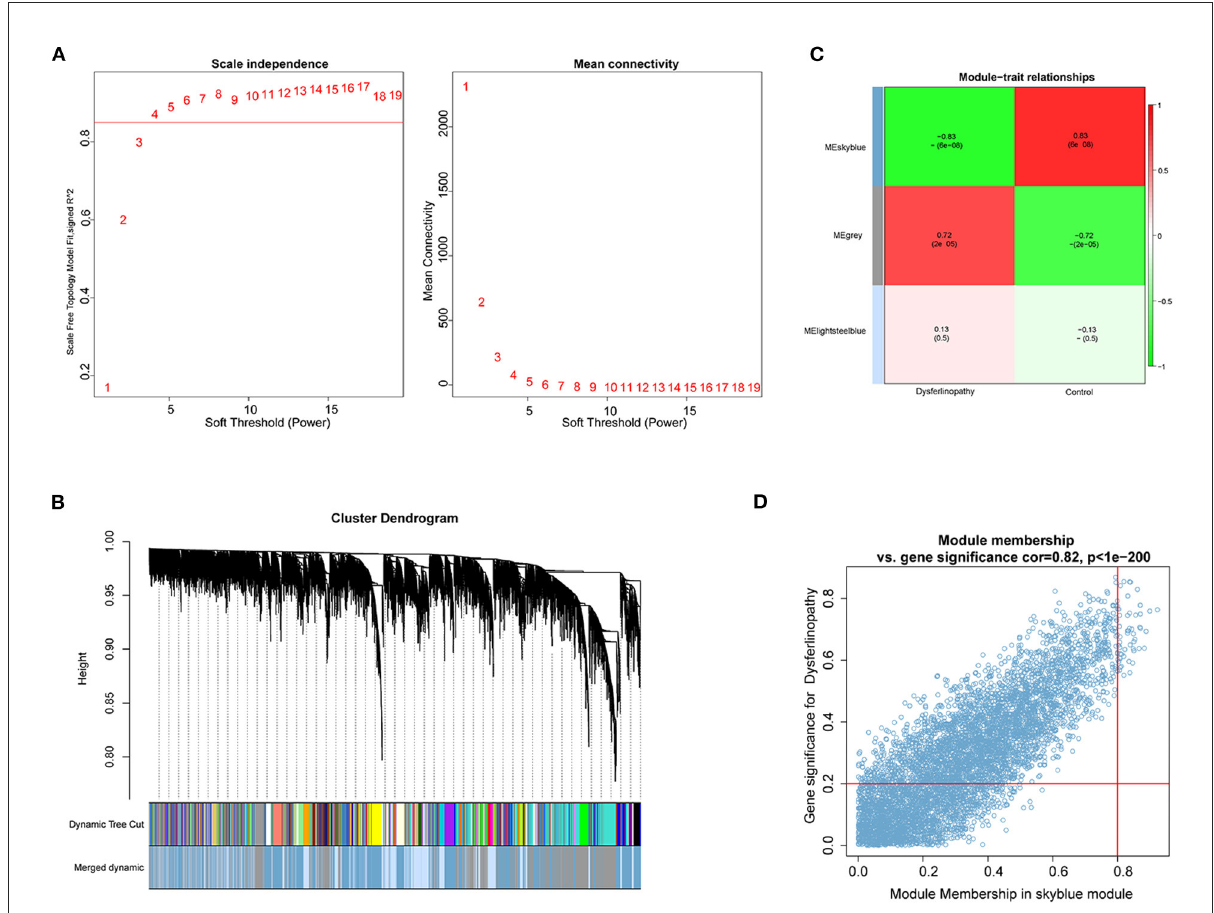
FIGURE2 Identification of key module based on WGCNA analysis. (A) Calculation of soft-thresholding power. A correlation coefficient of 0.9 and a soft-thresholding power of four are shown on the red line. (B) Gene cluster dendrogram on the basis of module eigengenes. The different colors represent different modules. (C) Module gene and clinical phenotype correlation analysis. The MEskyblue module was significantly associated with dysferlinopathy. (D) Scatter plot for correlation between genes within the MEskyblue module and clinical phenotype